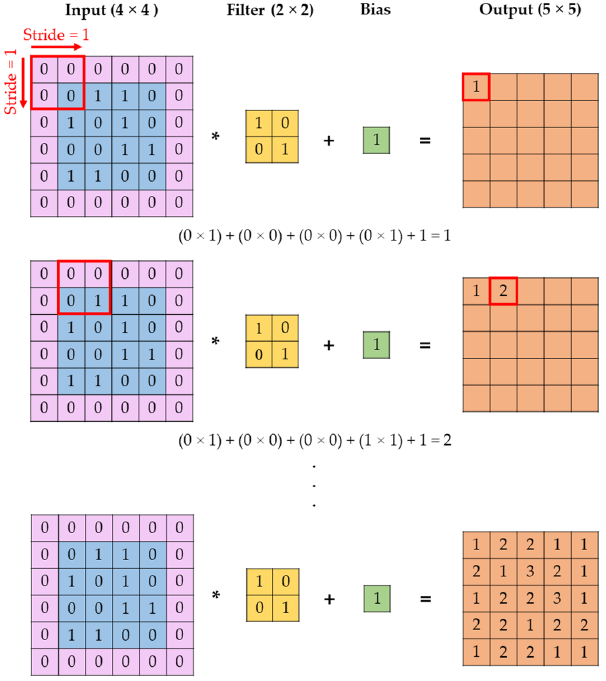
Figure 11. Convolution with zero padding.